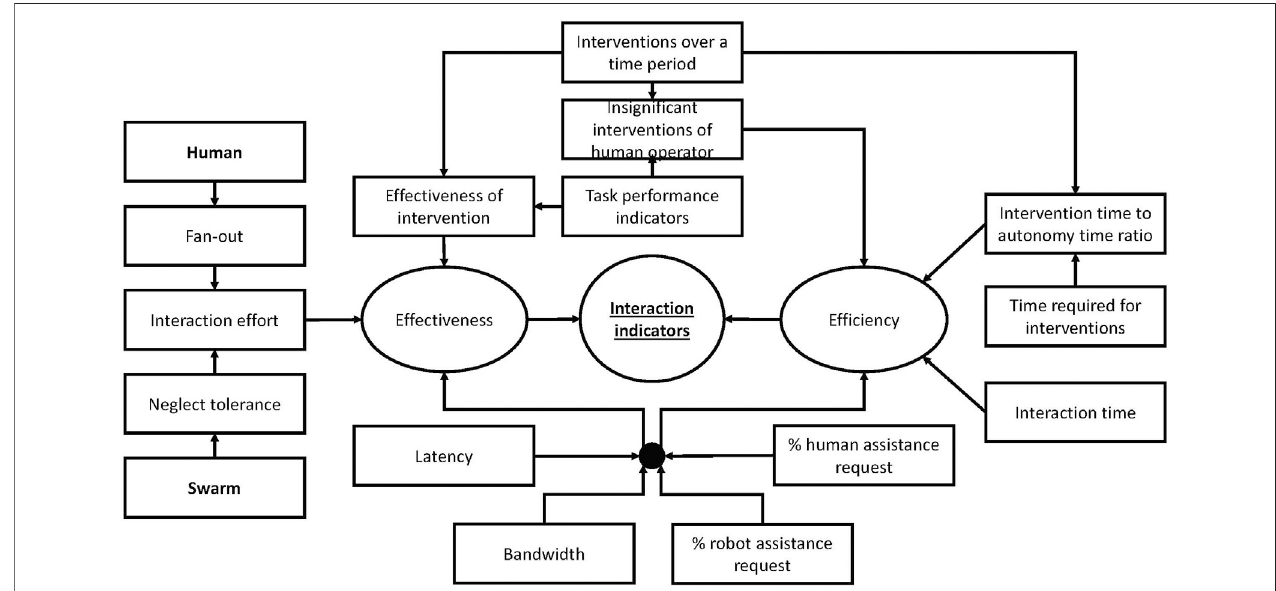
FIGURE 4 | An example of a set of interaction indicators.